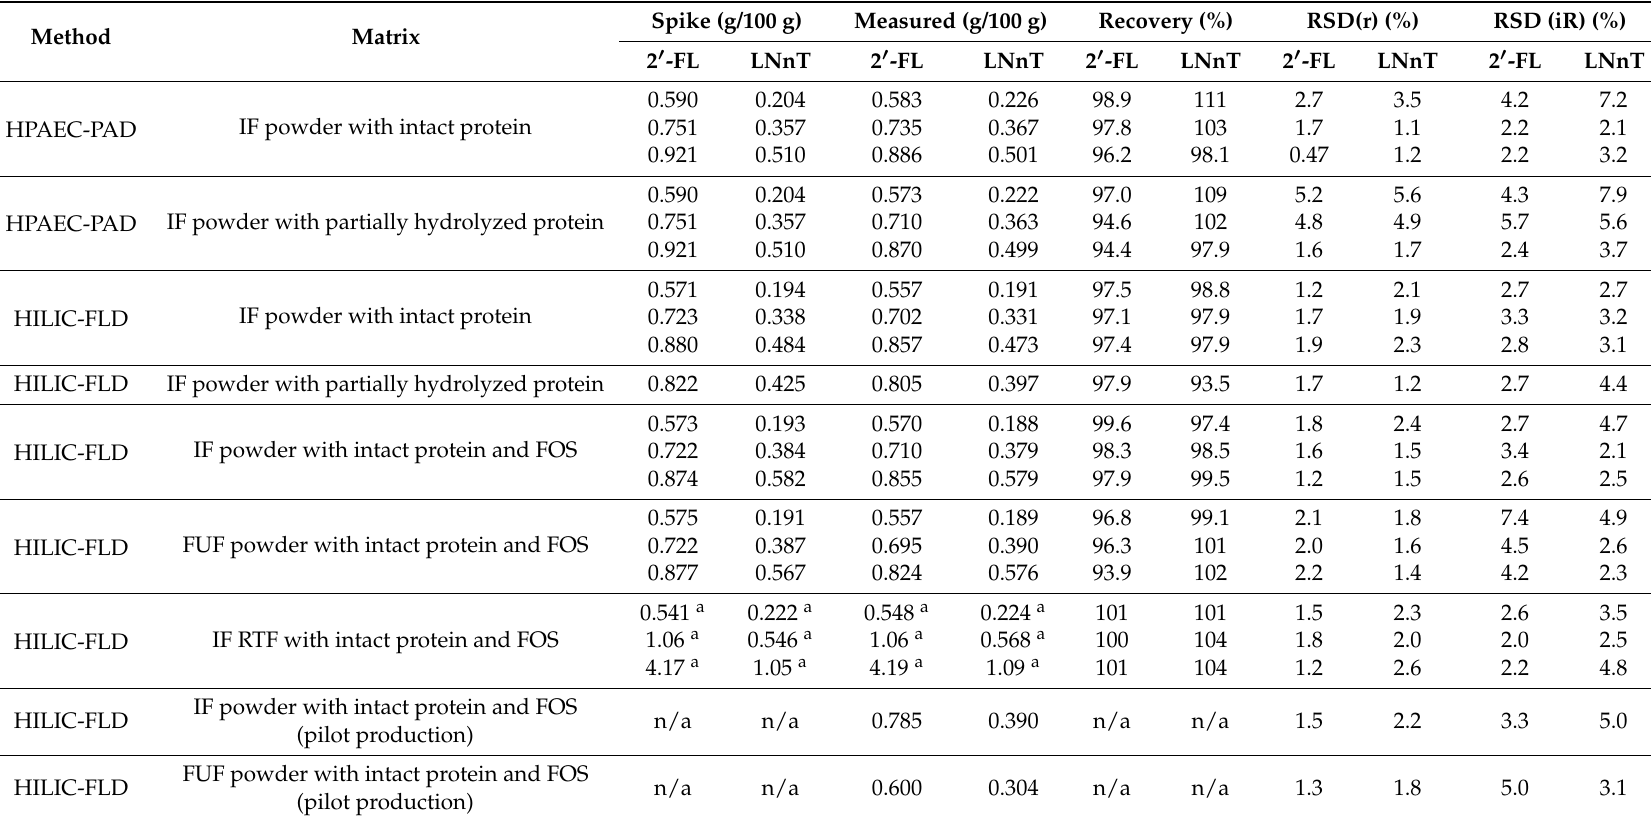
Table 2. Performance of the method determined during